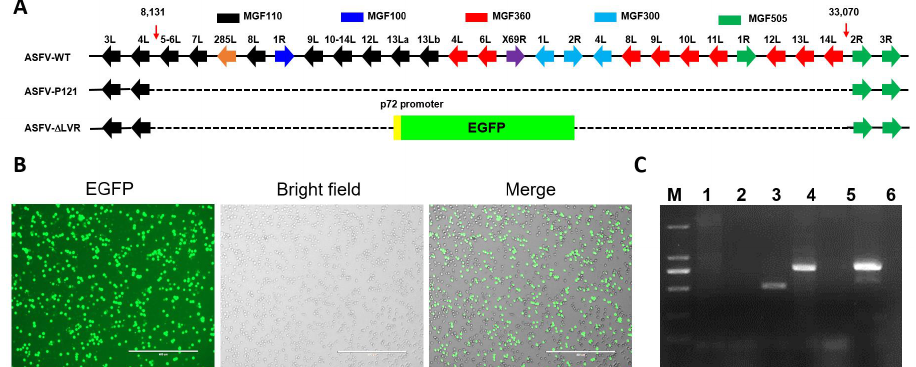
Figure 2. Construction and characterization of the LVR-deleting ASFV mutant. ( A ) Schematic diagram of ASFV- ∆LVR construction. The left variable region (LVR) MGF genes were replaced with the p72EGFP expression cassette via homologous recombination. ( B ) Purified ASFV- ∆LVR expressing EGFP. ( C ) PCR analysis of ASFV- ∆LVR stock. Line 1: ASFV- ∆LVR genome used as a template to amplify the MGF300-1L gene; Line 2: negative control with ddH 2 O as a template; Line 3: ASFV- WT genome used as a template to amplify the MGF300-1L gene; Line 4: ASFV- ∆LVR genome used as a template to amplify EGFP and left homology arm; Line 5: negative control with ddH 2 O as a template; Line 6: positive control with the transfer vector pOK12-p72EGFP- ∆ LVR as a template.